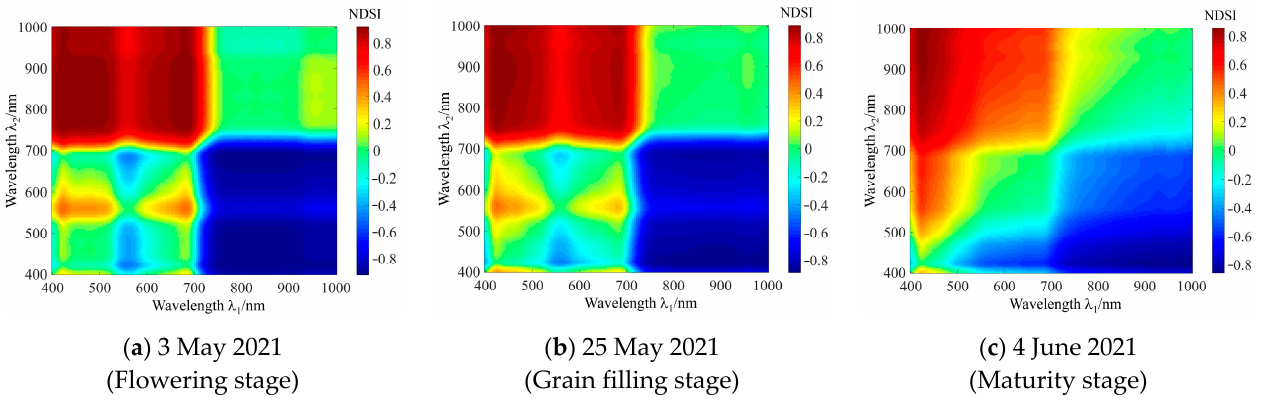
Figure 4. Two-dimensional distribution of UAV hyperspectral NDSI values of winter wheat.